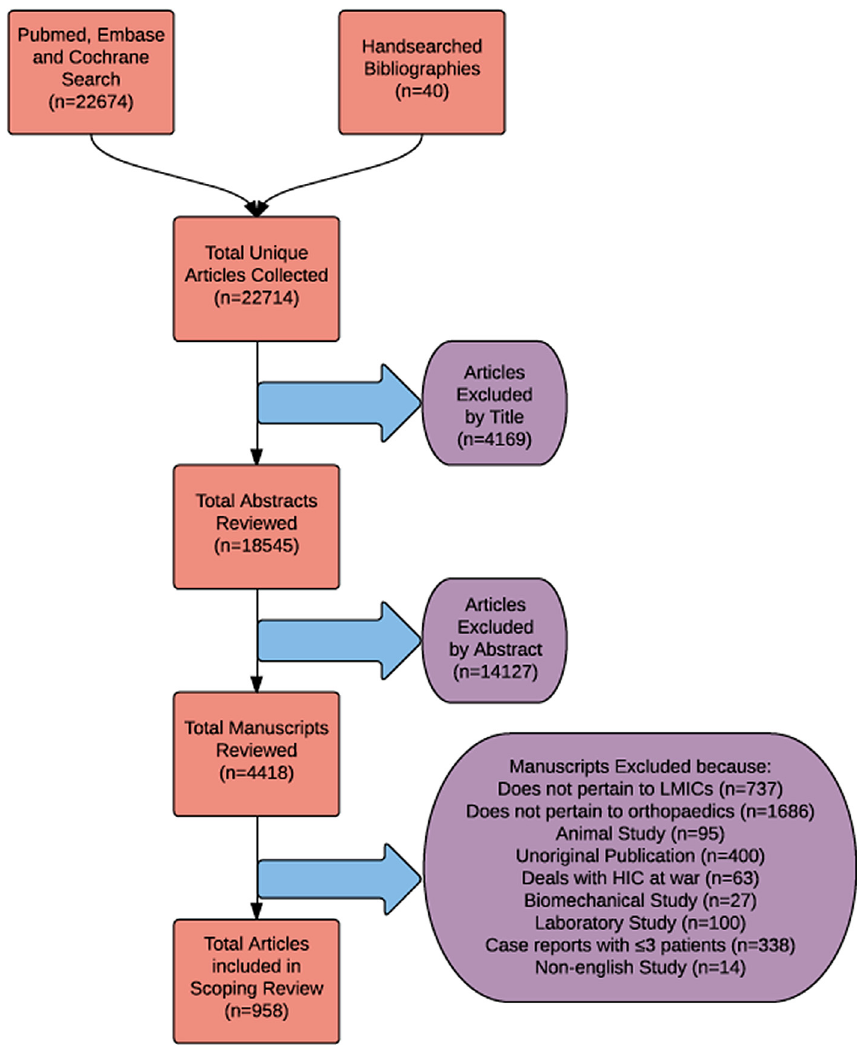
Figure 1. Flowchart shows included and excluded studies from search to data